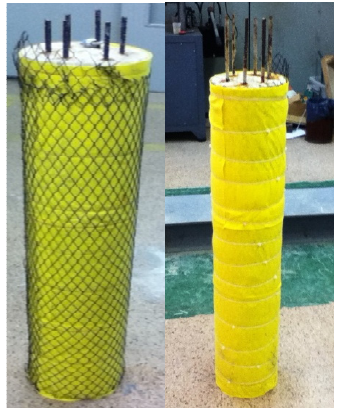
Figure 1. Anodic system composed by a Ti-RuO 2 mesh embedded between two absorbent polymeric layers, wrapping concrete